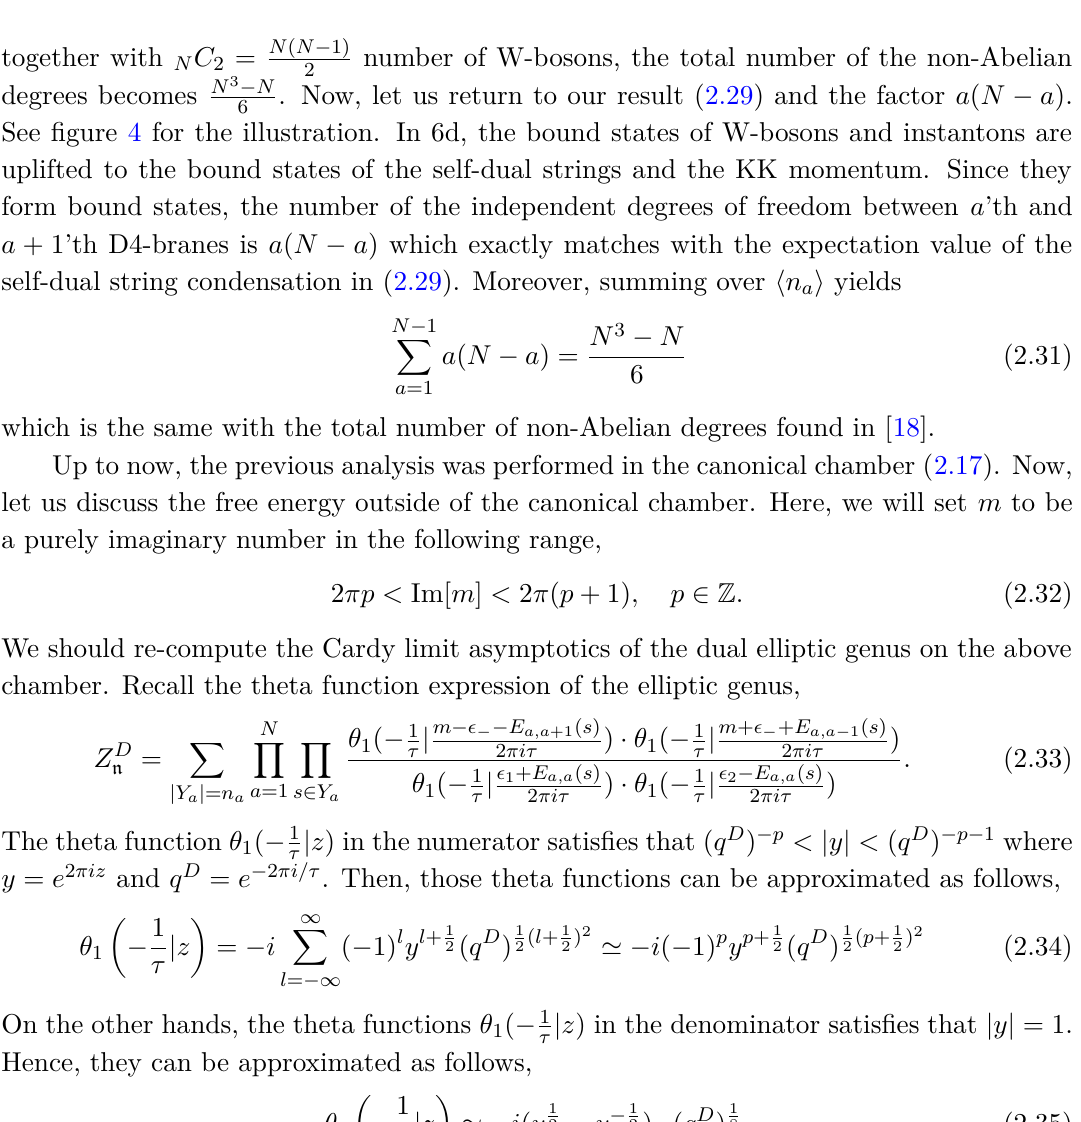
Figure 4. 6d (2,0) theory on N = 6 M5-branes. Orange lines denote the W-bosons, and the blue dots denote the KK instantons. Considering their bound states, the number of the independent degrees between a ’th and a + 1 ’th is proportional to a ( N − a )